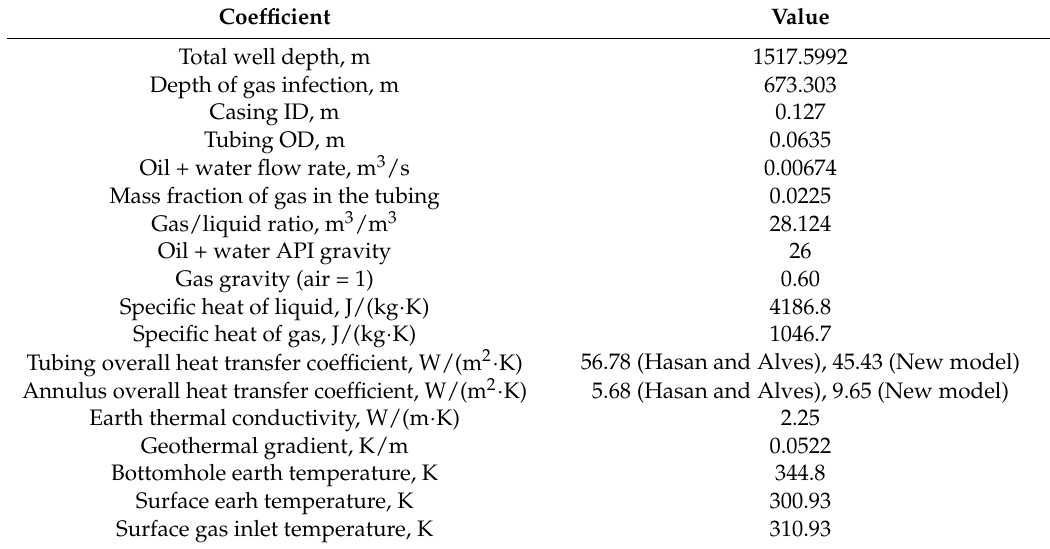
Table 6. Data for the O’Connor Well.